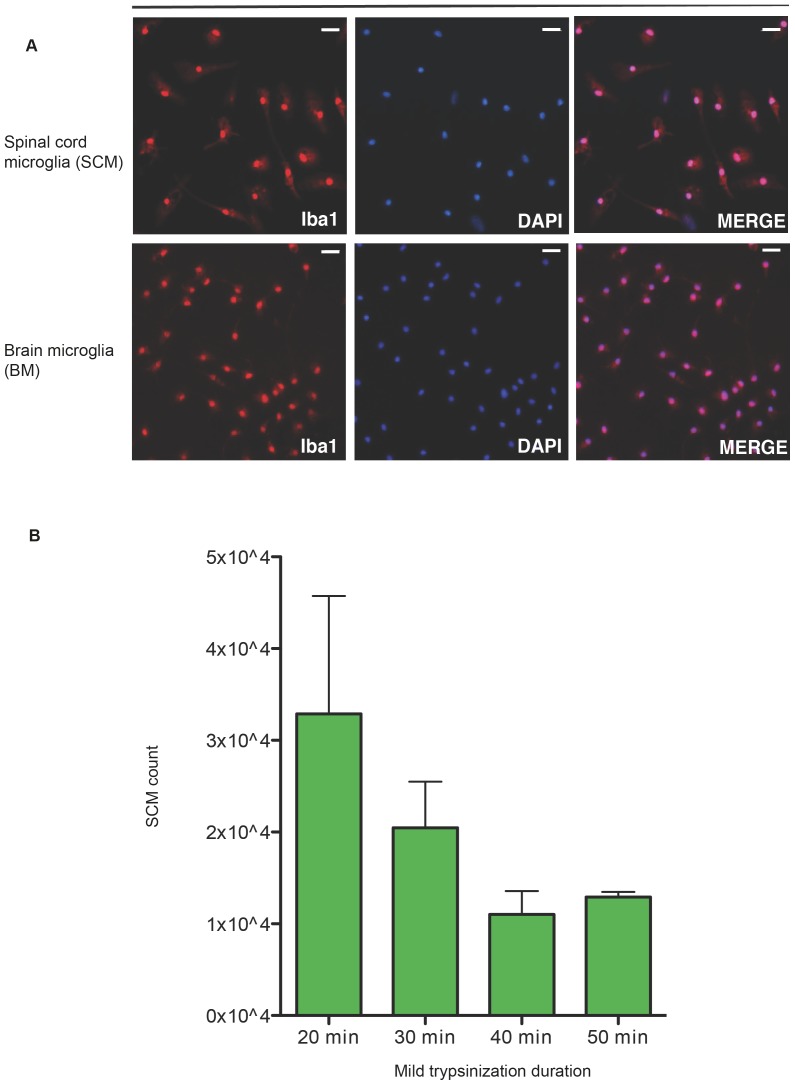
SCM isolation by mild trypsinization.(A) Representative micrograph of Iba1 labeled microglia derived from BM or SCM. Scale  = 50 µm. (B) 20 minutes of mild trypsinization had the highest yield of SCM. SCM counts were quantified from average of 6 fields each from four wells of 12 well cell culture plate (n = 4 where n represent the number of independent experiments, where an independent experiment is a separate microglia preparation).